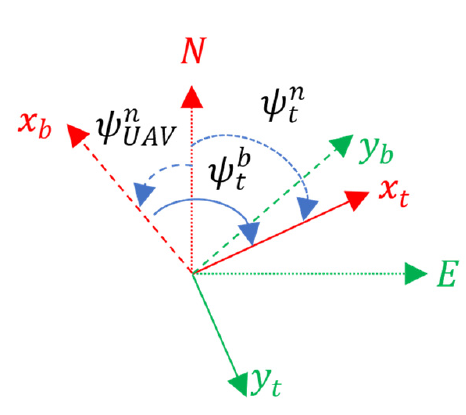
Figure 3. Helipad azimuth set formulation.